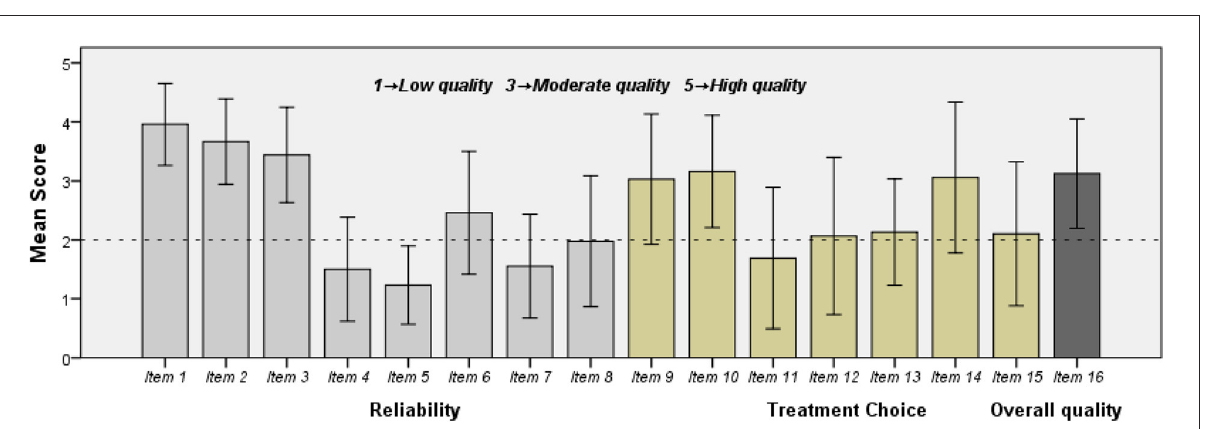
FIGURE2 The mean DISCERN score for each item. Error bars: + / − 1 SD (standard devision). Item 1. Clear aims. Item 2. Achieves aims. Item 3. Relevant. Item 4. Clear sources of information. Item 5. Clear date of publication. Item 6. Unbiased. Item 7. Provides additional sources. Item 8. Describes areas of uncertainty. Item 9. Describes mechanism of action for treatment. Item 10. Describes benefites of treatment. Item 11. Describers risks of treatment. Item 12. Describes what would happen without treatment. Item 13. Describes how treatment would affect life quality. Item